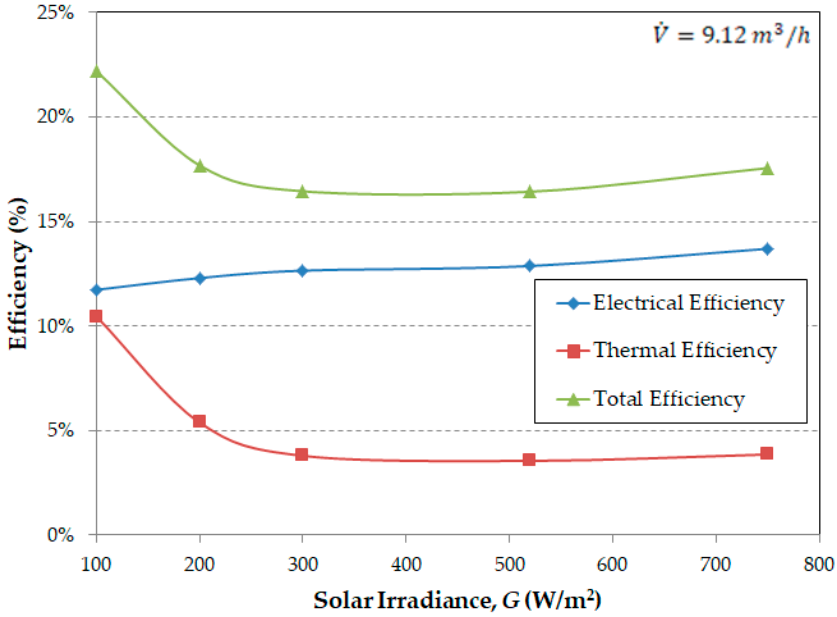
Figure 9. Efficiency changes depending on solar irradiance for a modified PV module, cooled by fans with the intensity of airflow at 𝑉(cid:4662) = 9.12 (cid:2923)